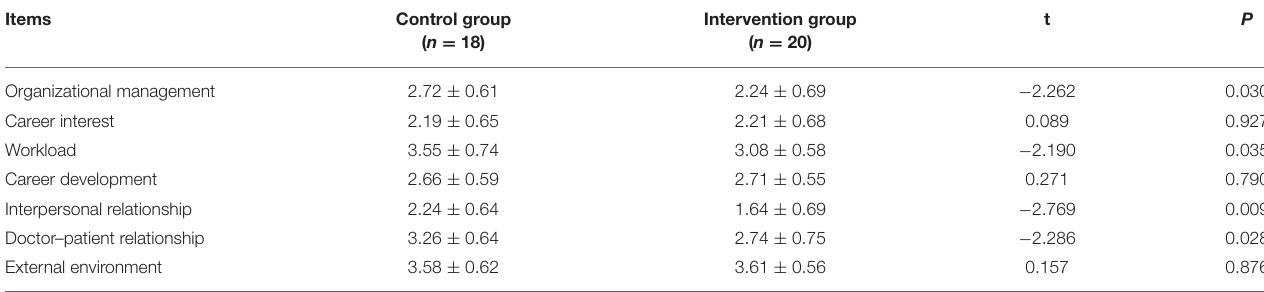
TABLE 4 | The Chinese Physician’s Job Stressor Scale (CPJS) in the two groups ( x ± s).